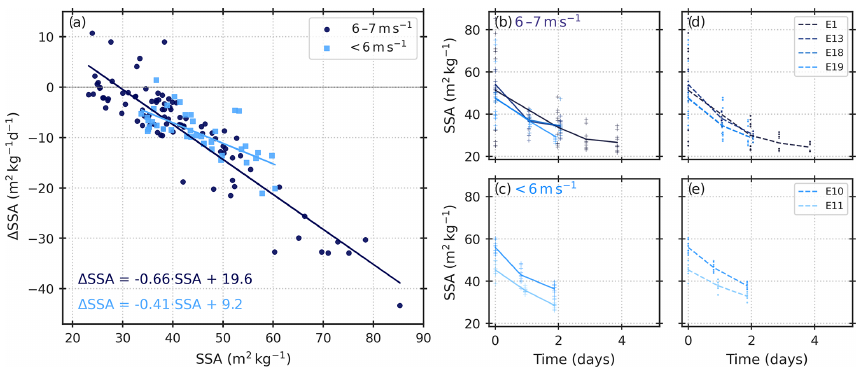
Figure 4. Linear regressions for change in SSA against the SSA for the low-wind (light blue) and moderate-wind (dark blue) SSA decay events (a) considering all individual samples. The observed SSA decays are shown for the moderate-wind events (b) , and the low-wind events (c) , followed by the modelled SSA decays for the respective events in (d) and (e) . The legend in (d) and (e) corresponds to the SSA decay event number in Table A1.